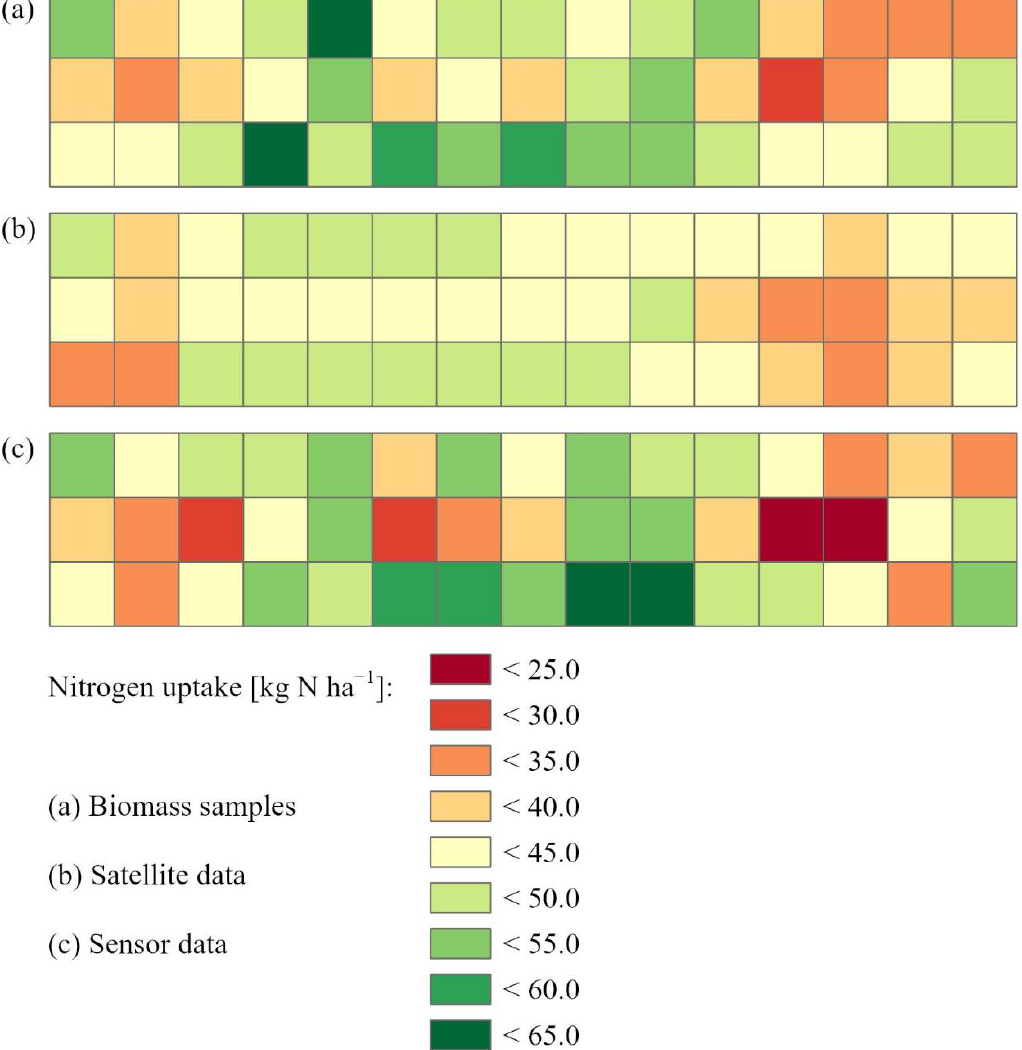
Figure 4. Nitrogen uptake 2021, BBCH 31. Nitrogen uptake was determined from the biomass samples, sensor data, and satellite data. Table 5. Coefficients of determination (R 2 ): nitrogen uptake data for 2020 ( n = 30) and 2021 ( n = 45).